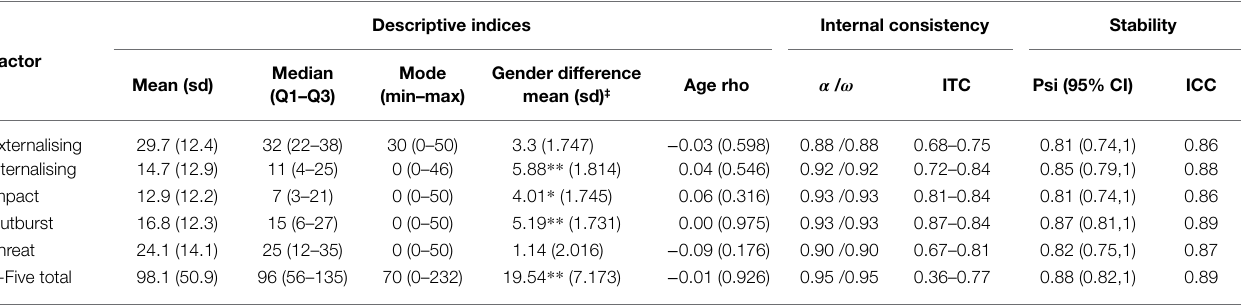
TABLE 2 | Norms and reliability of the S-Five 5 factors and total scores ( N =